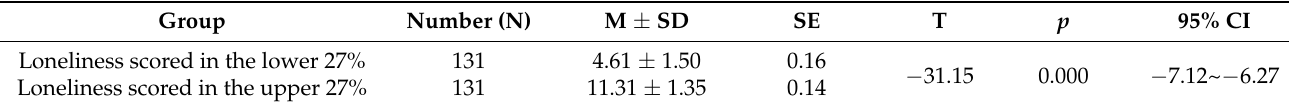
Table 3. Confirmatory t -test for stratification of the loneliness level.